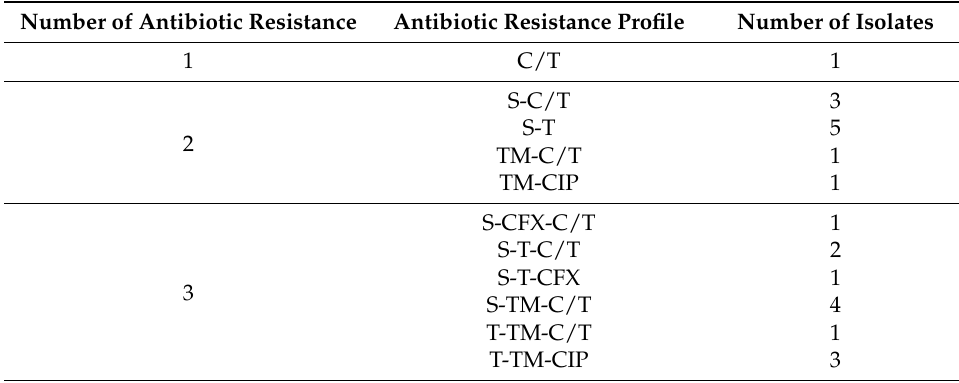
Table 3. Phenotypic profiles of antibiotic-resistant